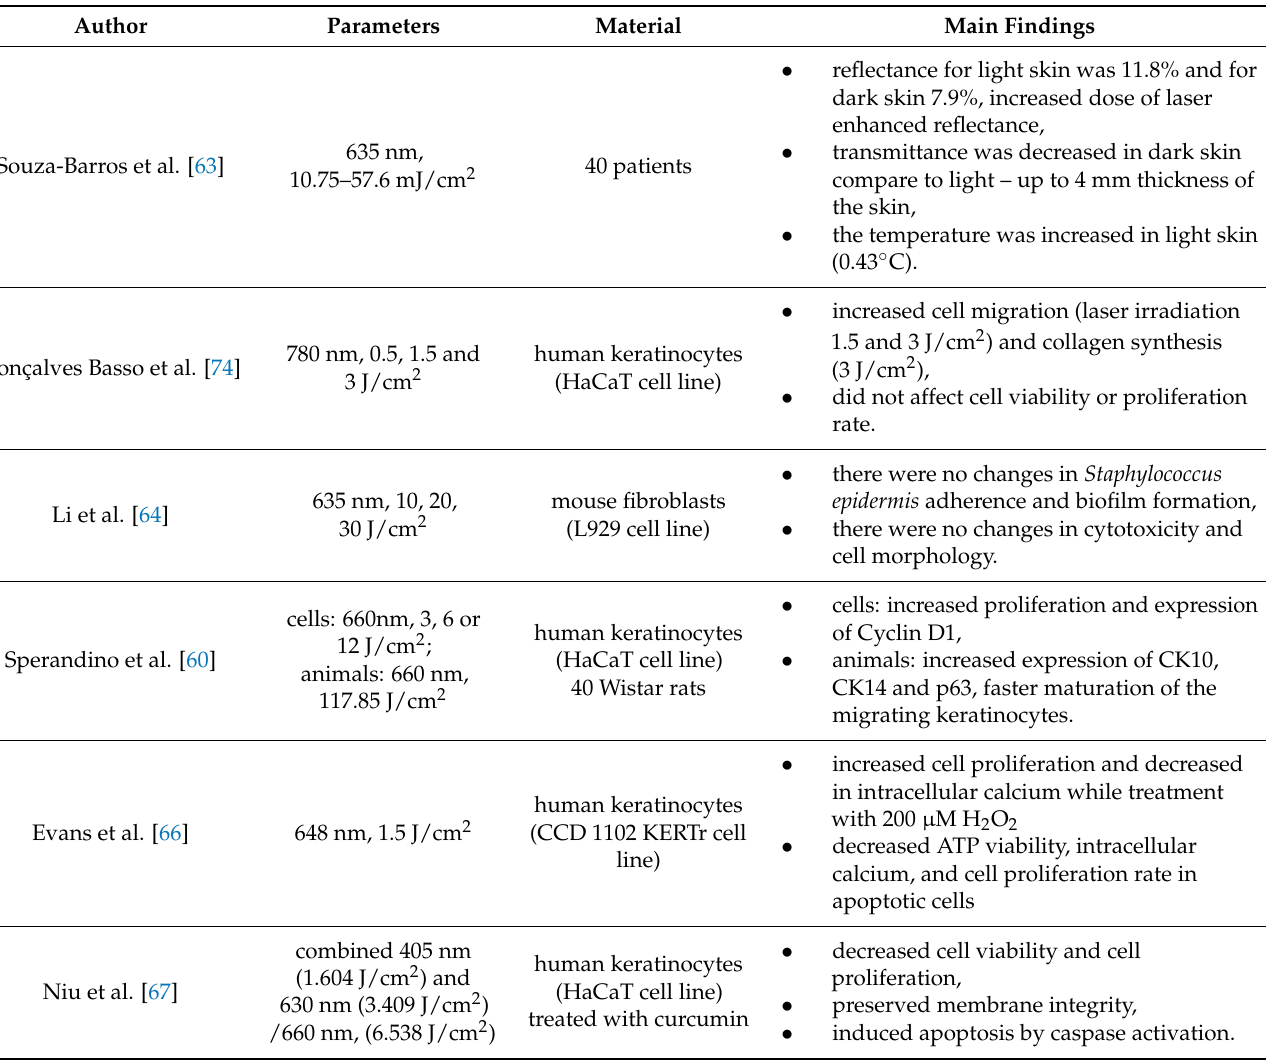
Table 4. Red light (620–740 nm) effects on skin